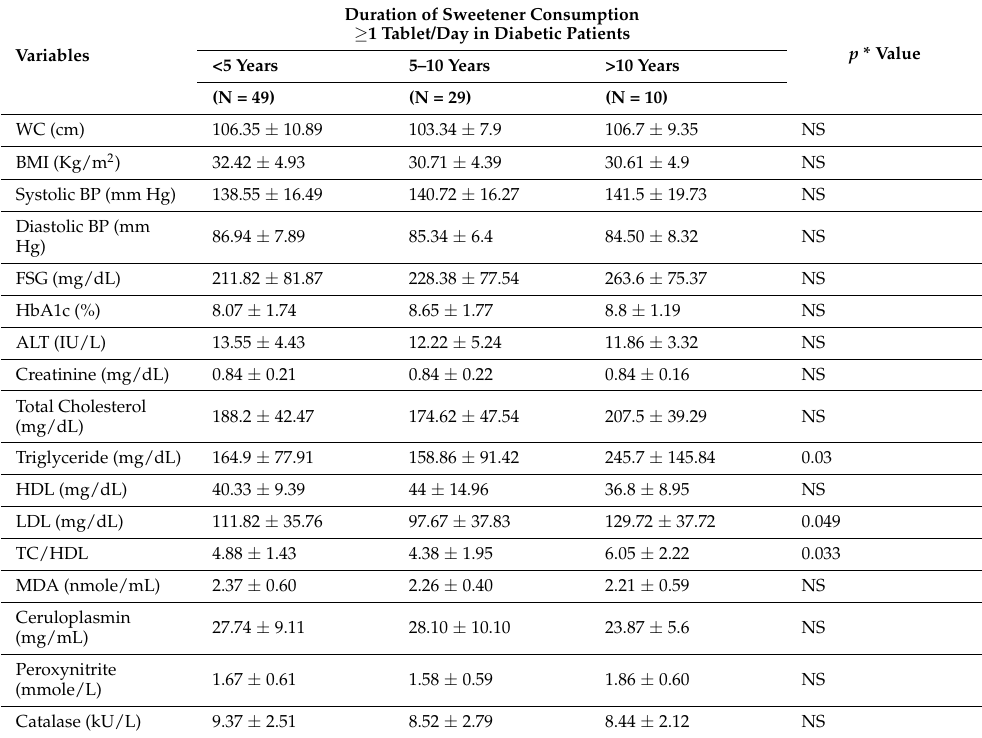
Table 5. Impact of artificial sweeteners long-term consumption among type 2 diabetic patients.